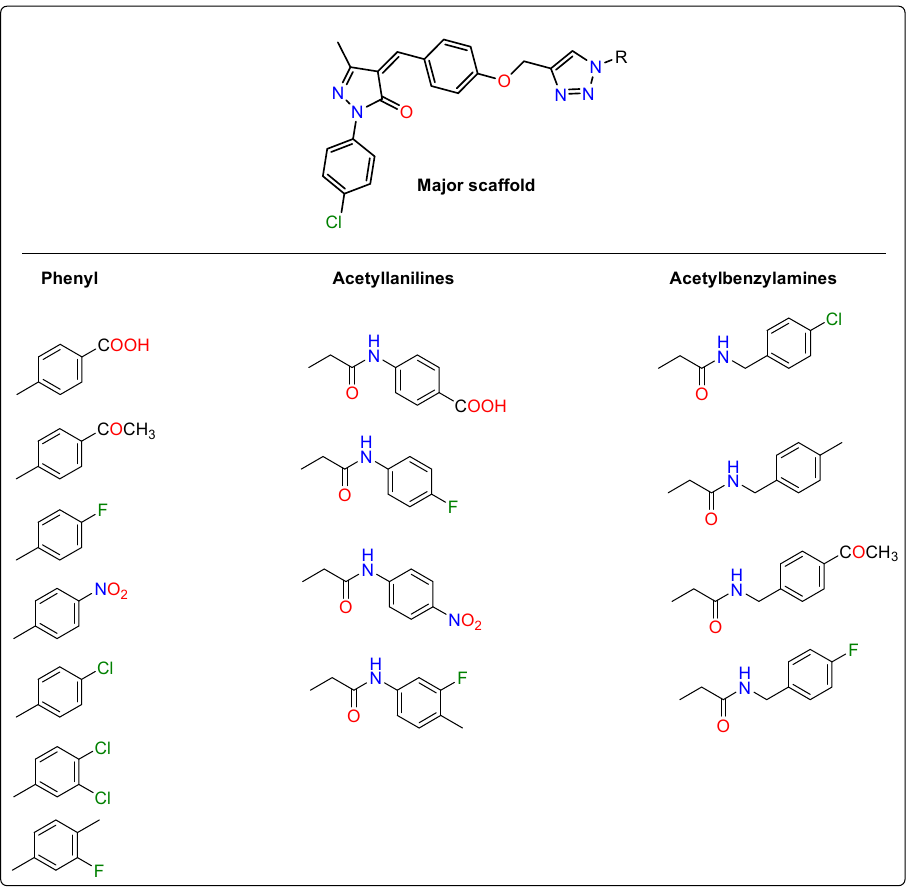
Figure 4. Structure-activity relationship screen of the anti-SARS-CoV-2 Main protease of target compounds showing the most proper fragments within different scaffolds.